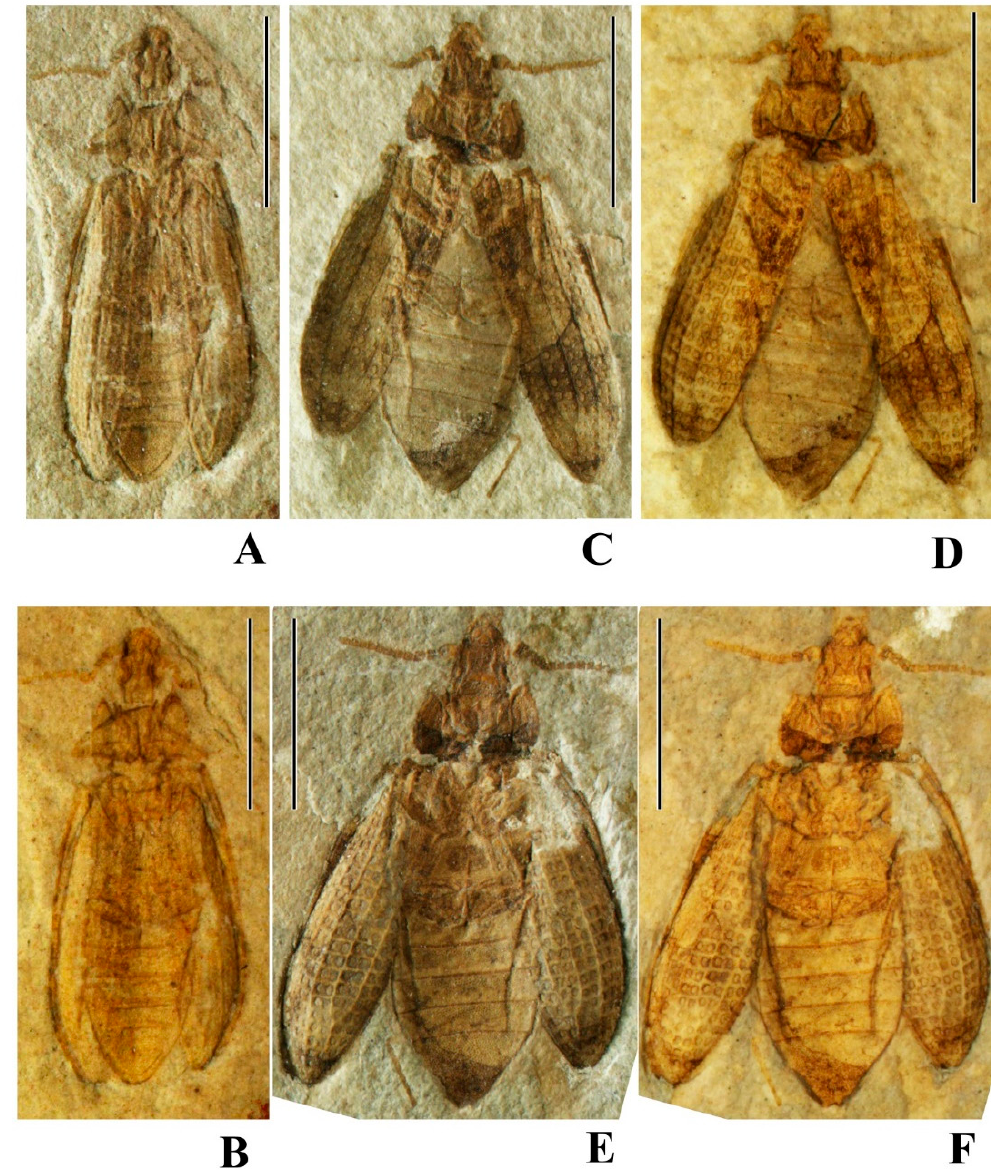
Figure 18. Ommatinae (Cupedidae): A-B Zygadenia aliena comb. nov. [ Ovatocupes ], holotype CNU—C-LBC2005001(Lower Cretaceous, Lower Aptian; Liaoning, Chaomidian): A —dry, B —wettened by alcohol; length of print 9.5 mm, scale bar = 4.0 mm; original. C – F — Zygadenia minuscula comb. nov. [ Amblomma, Notocupes ], holotype, CNU—C-LB2005005-1, part and CNU –C-LB2005005-2, counterpart (Lower Cretaceous, Lower Aptian Liaoning, Chaomidian); C —part, dry, D —same, wettened by alcohol; E —counterpart, dry, F —same, wettened by alcohol; length of print 10.0 mm, scale bar = 4.0 mm; original. Kyrgyzstan: Osh Region (Madygen, Dzhailoucho area); Middle / Upper Triassic, Ladinian / Carnian, − 235.0–221.5 Ma; Osh Region (Kyzyl-Kiya); Lower Jurassic, Pliensbachian, − 189.6–183.0 Ma; Tonskiy (Ak-Bulak-Say, Sogjuta, Issyk-Kul); Upper Triassic / Lower Jurassic, Rhaetanian / Hettangian, − 201.6–189.6